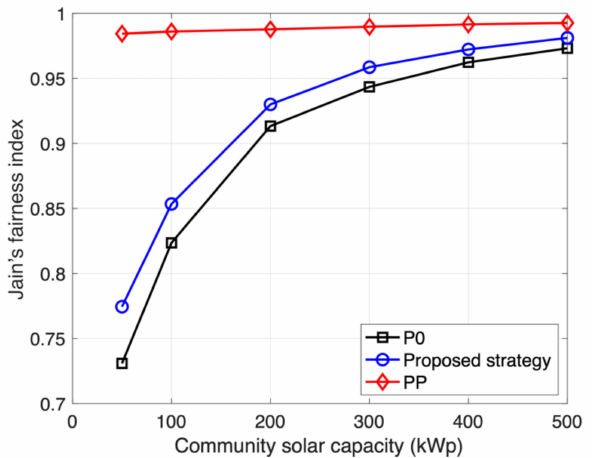
Figure 9. Jain’s fairness index based on the electricity bill savings per allocated capacity of each